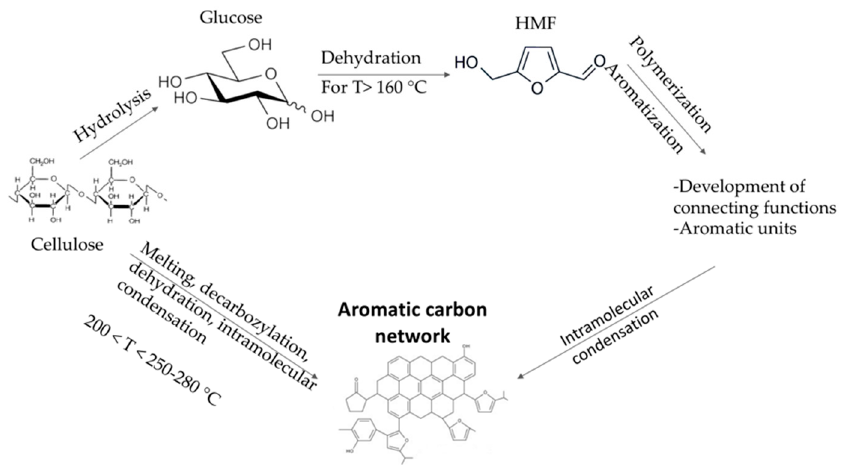
Figure 2. Cellulose conversion pathways, as proposed in Titirici, 2012.